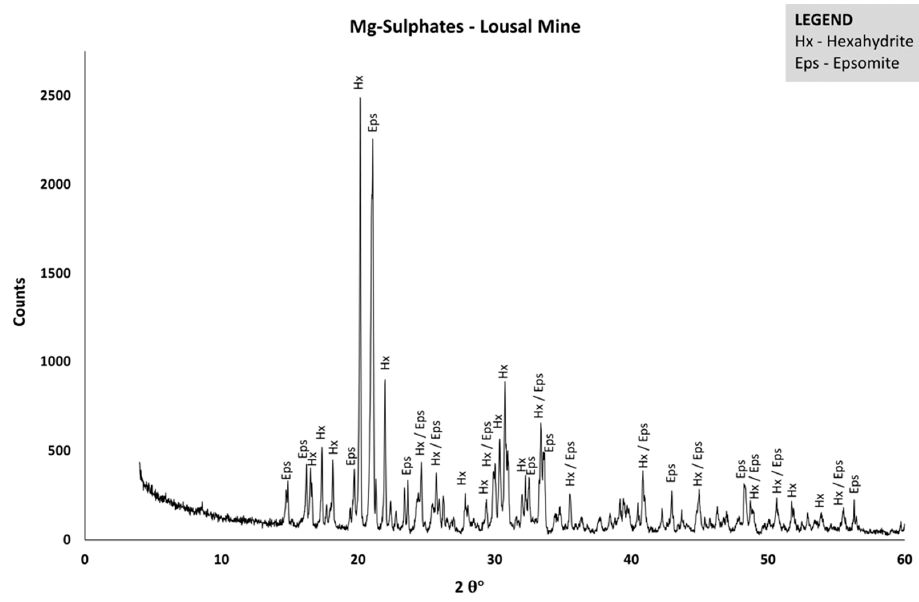
Figure 4. X-ray diffractogram showing the dominance of Mg-sulfates (epsomite and hexahydrite) on site L1.